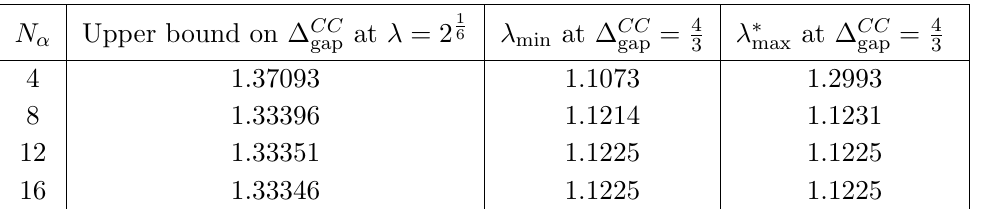
Table 3. The width in (cid:21) and the extent in (cid:1) CC numerical bootstrap in the case of c = 3 and external charge q = 1 (cid:21) at which (cid:1) CA = 1 , the reason being that the bounds on (cid:1) CA gap 2 derivative order but approach zero as the derivative order is increased.